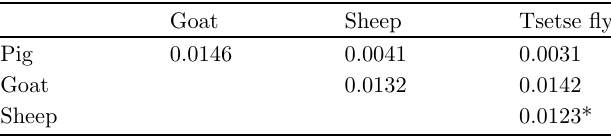
Table 6. F ST values between subpopulations of T. congolense “ forest type ” by trypanosome